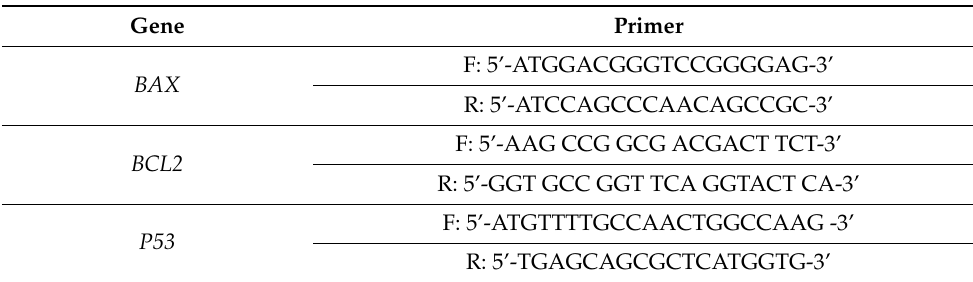
Table 1. Specific primers of BAX , BCL2 and P53 used to perform qRT-PCR analysis for PC-3 cells in response to A. vulgaris root extract treatment.